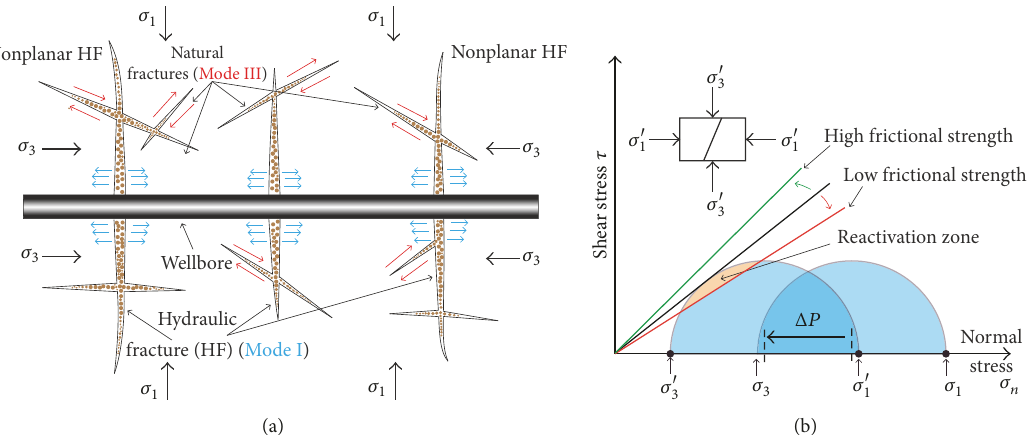
Figure 1: (a) Schematic of complex fracturing system filled with proppant after multistage hydraulic fracturing; (b) Mohr-Coulomb criterion for determining whether a preexisting fracture would be sheared after a combined effect of local stress reorientation and frictional